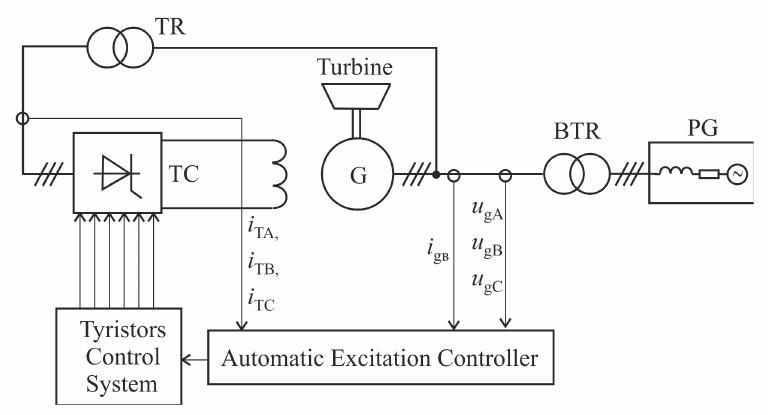
Figure 1. Static excitation system of synchronous generators: G—synchronous generators; BTR—generator’s transformer; PG—power grid; TR—input transformer of excitation system; TC—thyristor